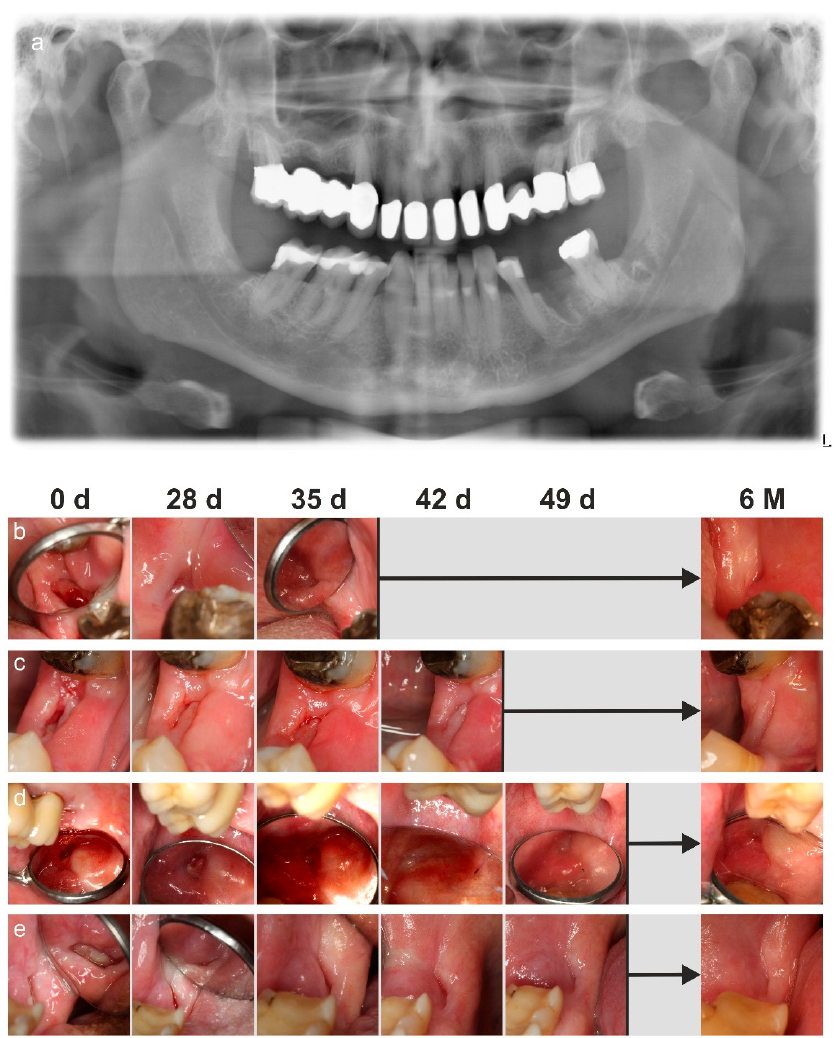
Figure 2. A 63-year-old patient receiving zoledronate for oncological reasons developed wound dehiscence 2 weeks after tooth extractions. ( a ) Panoramic X-ray at first presentation showing